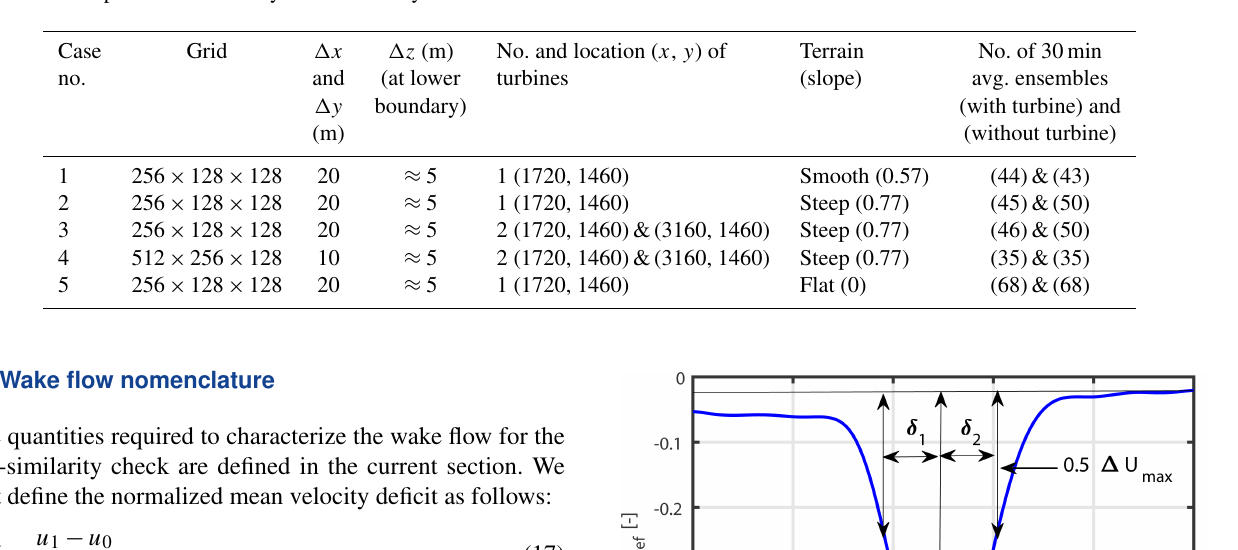
Figure 3. Comparison of terrains with two different slopes along the main transect. Table 1. Description of cases analyzed in the study.